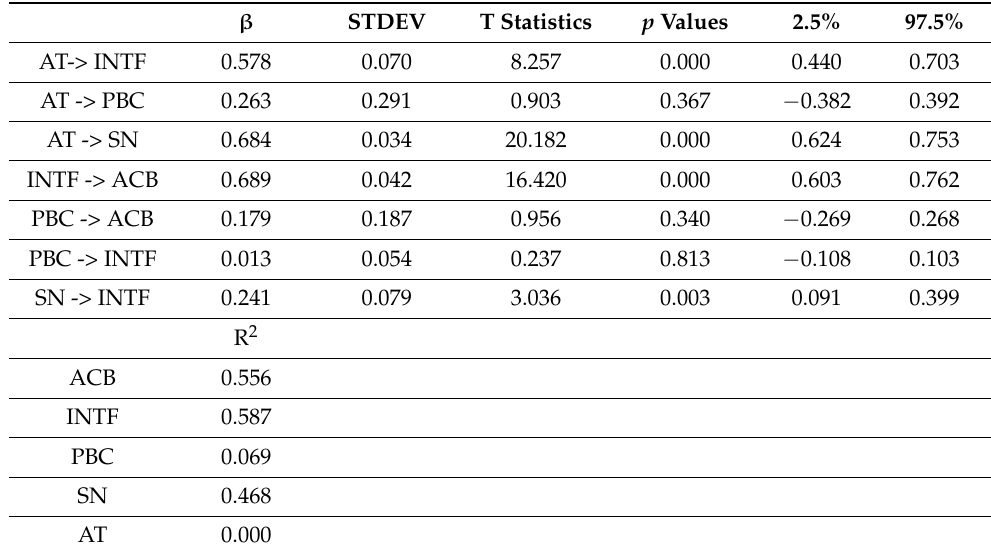
Table 8. Mean, STDEV, T-Values, p -Values,